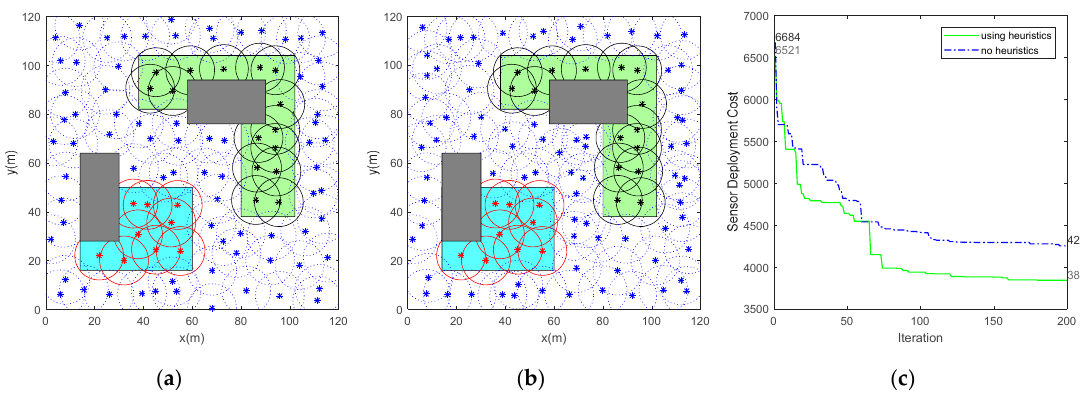
Figure 6. ( a ) Sensor deployment using improved cooperatively coevolving particle swarm optimization (CCPSO2) with heuristic rules. ( b ) Sensor deployment using normal CCPSO2 with no heuristic rules. ( c ) Sensor deployment cost for two situations.